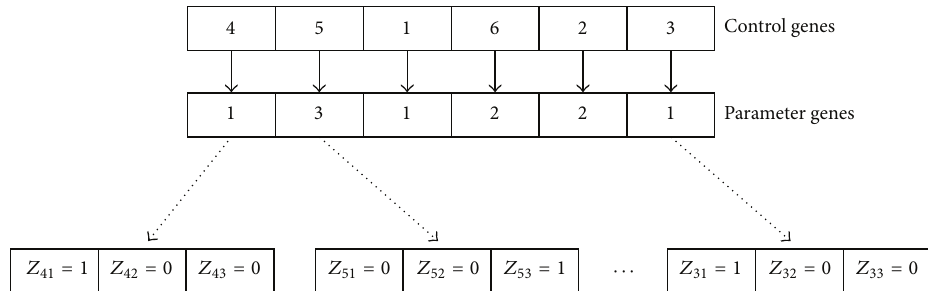
Figure 2: The process of natural number